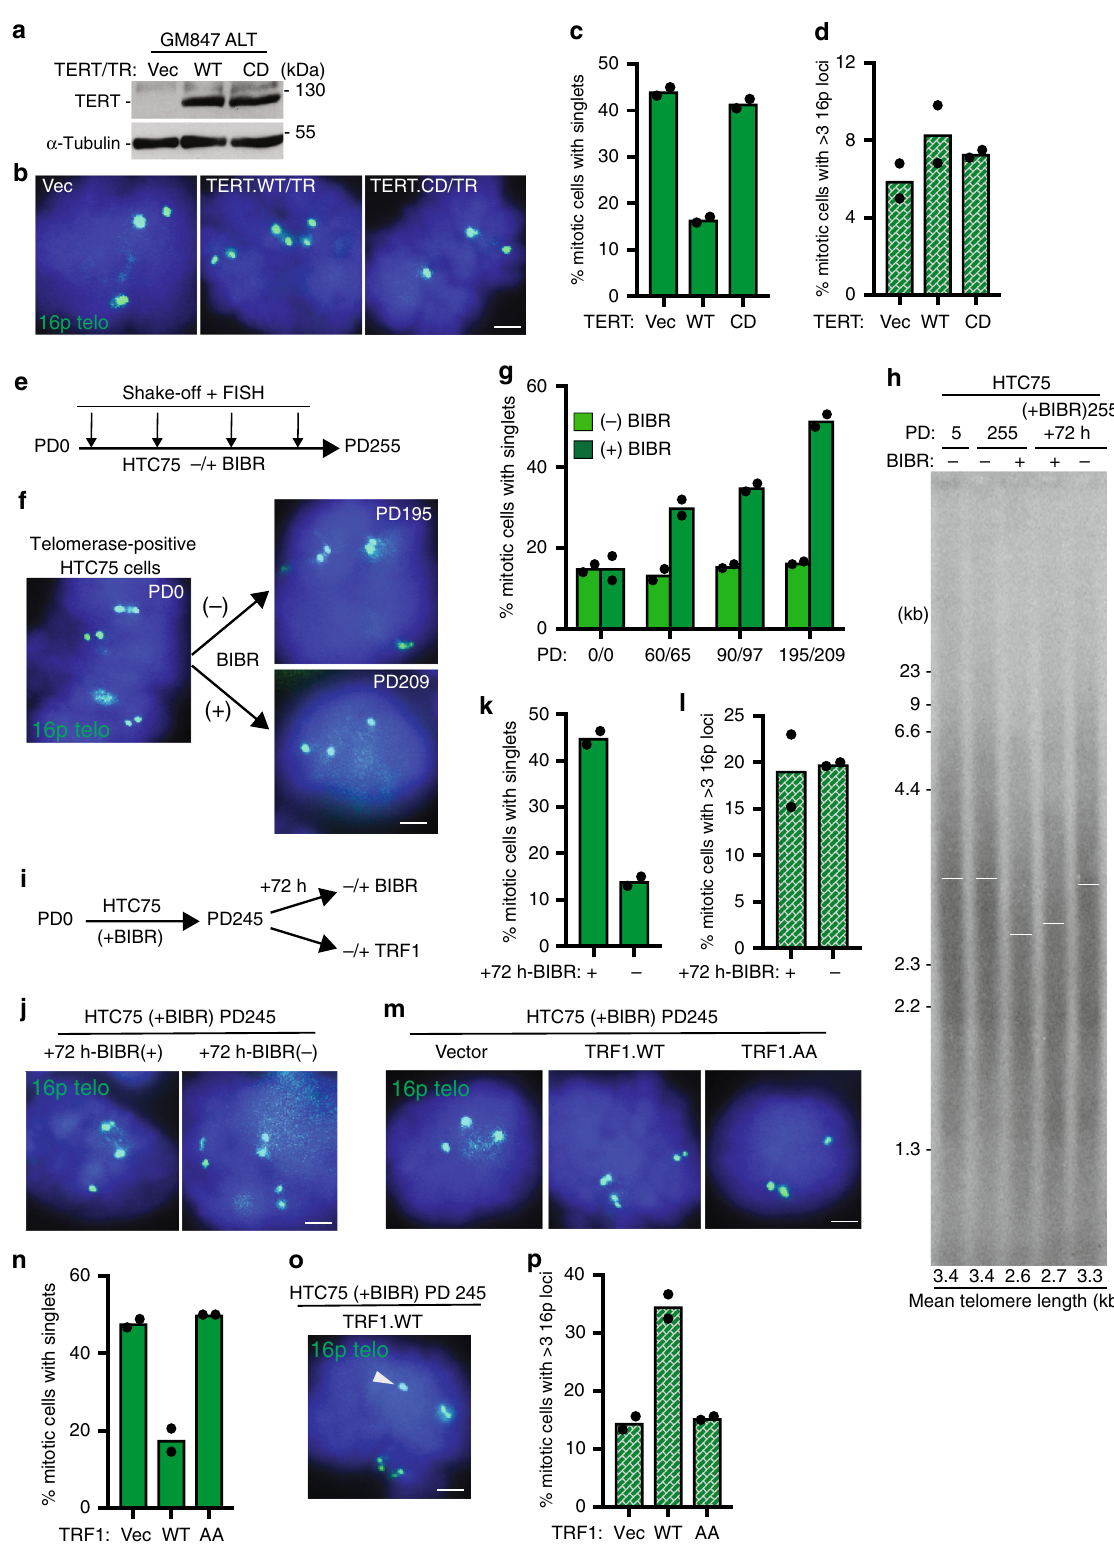
Methods Cell lines . WI38 and IMR90 fi broblast cell lines (ATCC) were supplemented with 20% FBS and grown in standard conditions. For aged WI38, cells were